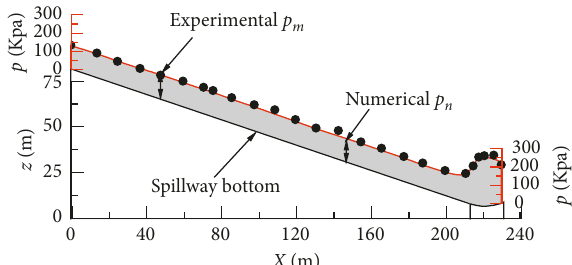
Figure 9: Pressure distribution on the central line of the chute soleplate.